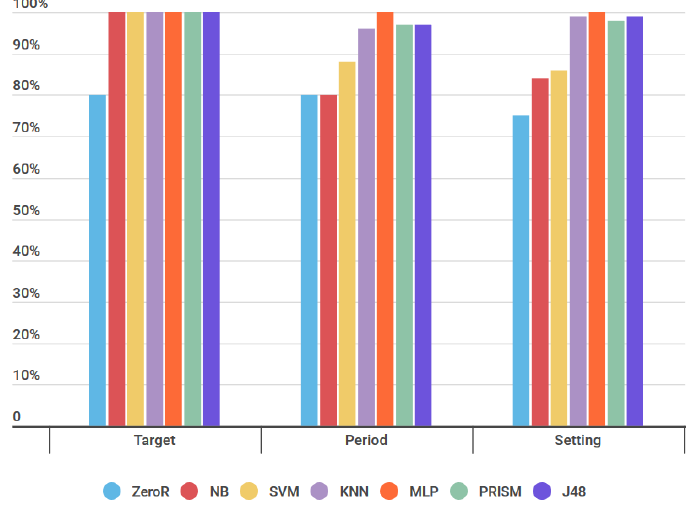
Figure 8. Baseline